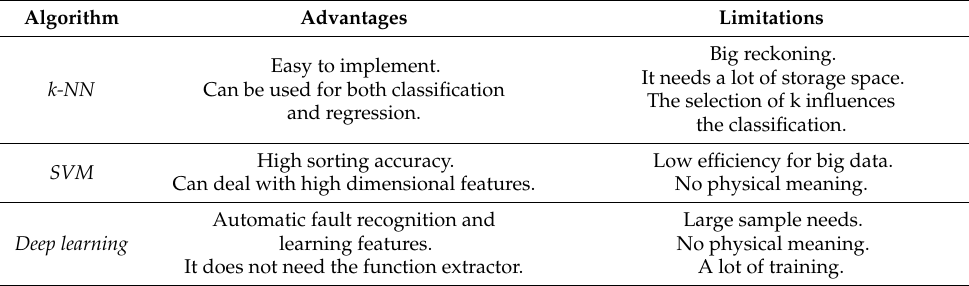
Figure 1. Comparison between machine and deep learning methodology. Table 1. Artificial intelligence: advantages and limitations.